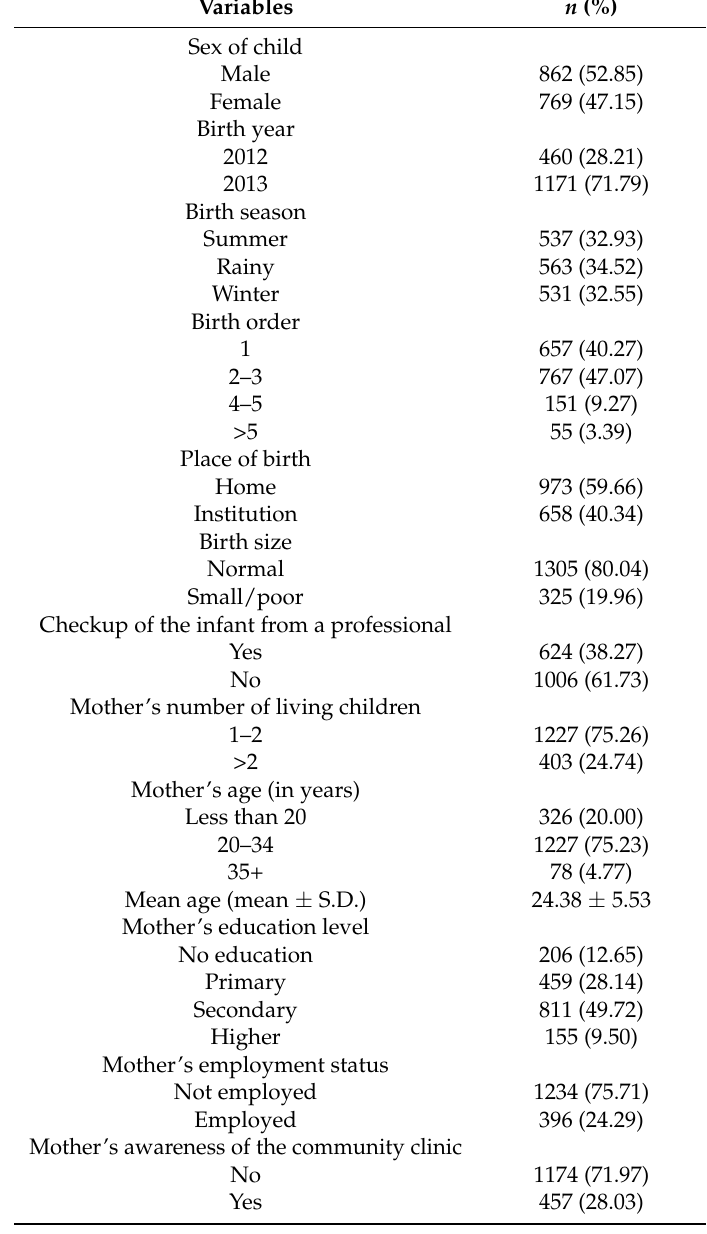
Table 2. Distribution of background characteristics of the study participants ( n =